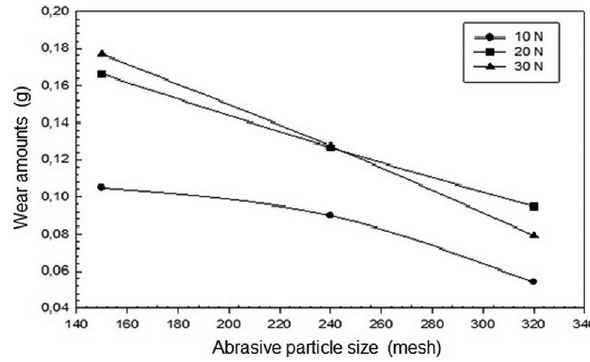
Fig. 13: Weight loss of the 3% reinforcement volume ratio composites manufactured at 800 °C temperature and 500 rev/min